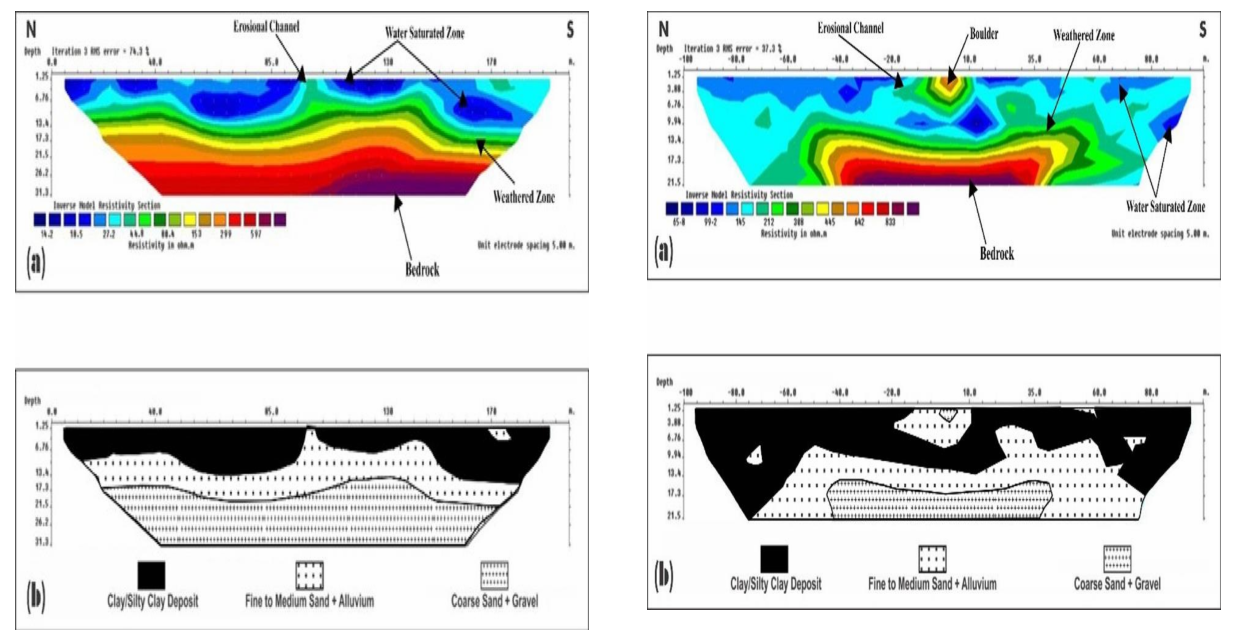
Fig. 6. (a) Profile 3 electrical resistivity tomography; (b) Geologic cross-section interpreted from the resistivity model within a sequence of horizontal sedimentary sequence (see Fig. 3).